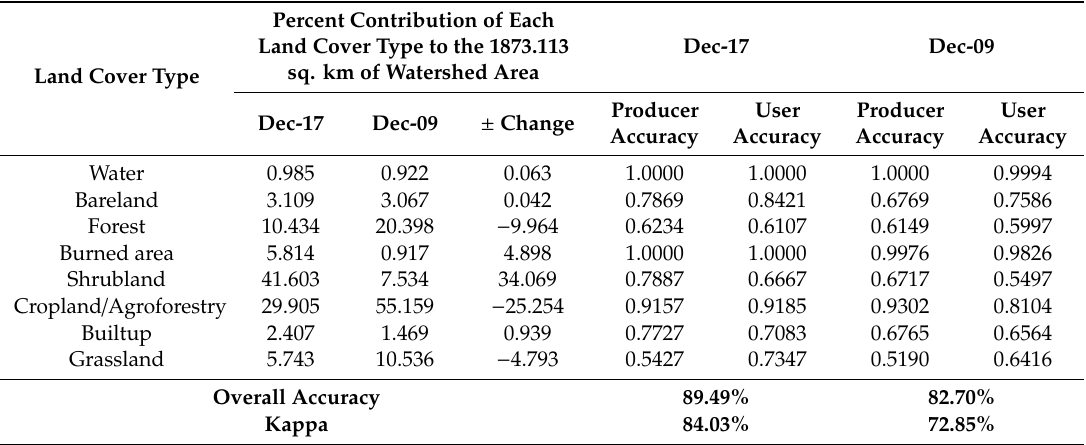
Table 1. Percent area, producer, and user accuracies for the individual classes of land use for December 2017 and December 2009 of the ASTER satellite